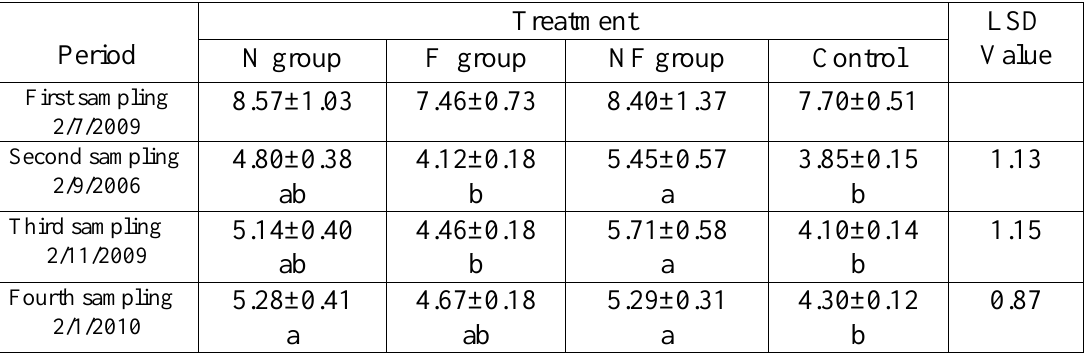
Different letters show significant differences among treatments at one period at5% level .